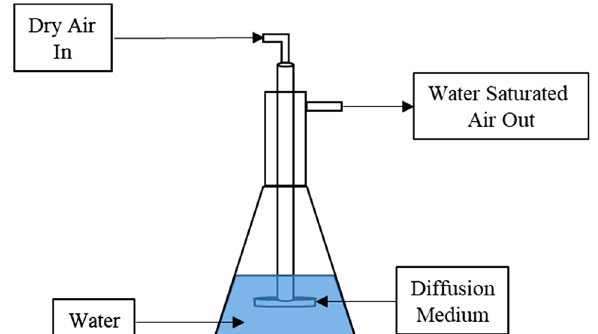
Figure 1. Conceptual water sparger